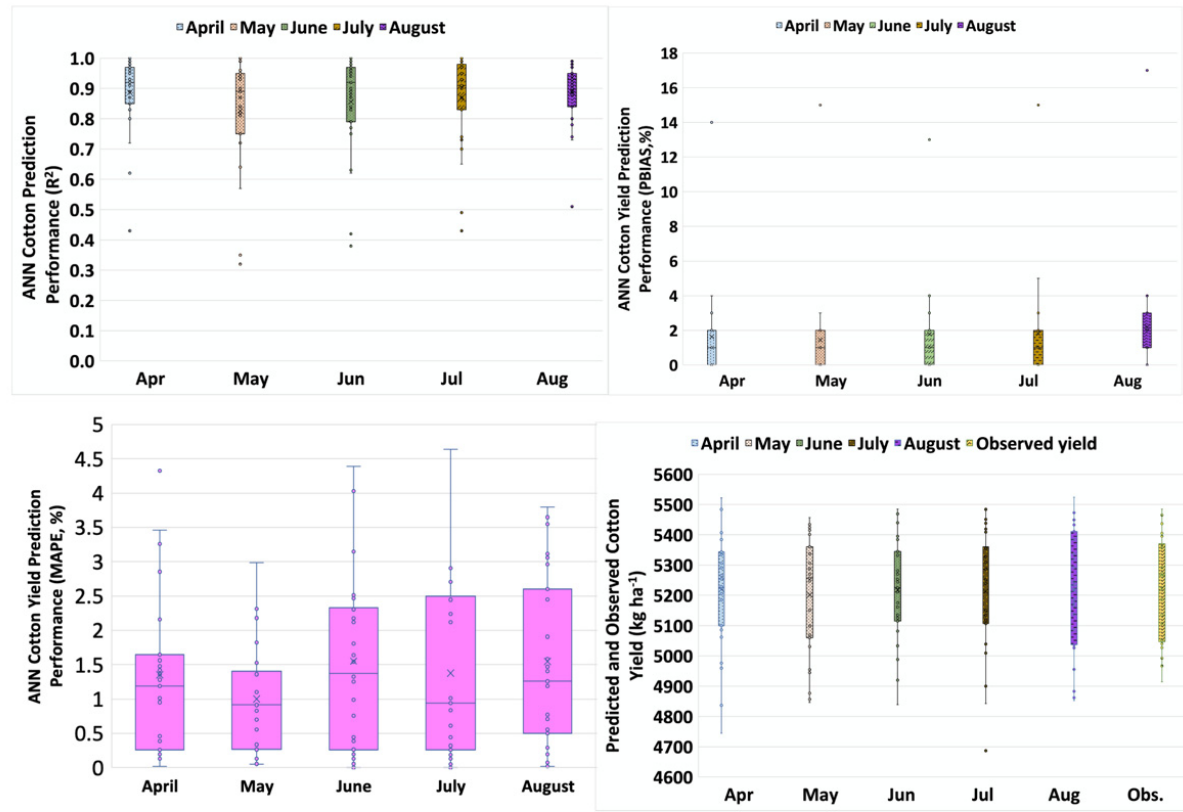
Figure 5. ANN cotton yield prediction performance and the predicted and observed values.